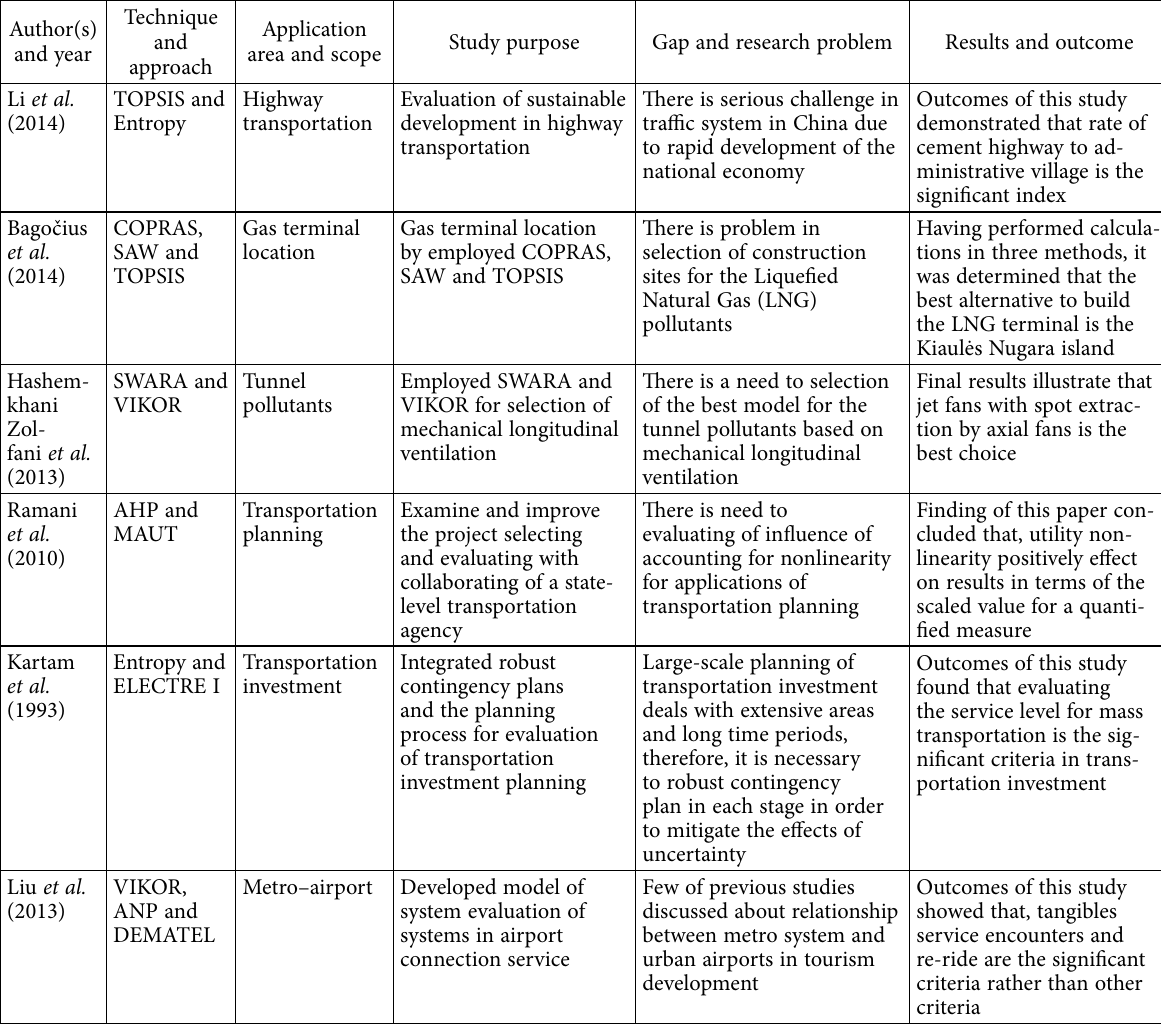
Table 5. Distribution based on hybrid MCDM and